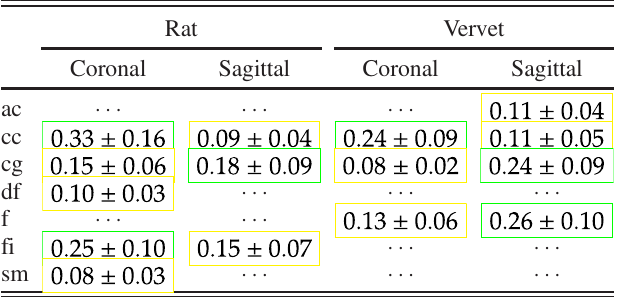
) and standard T;N